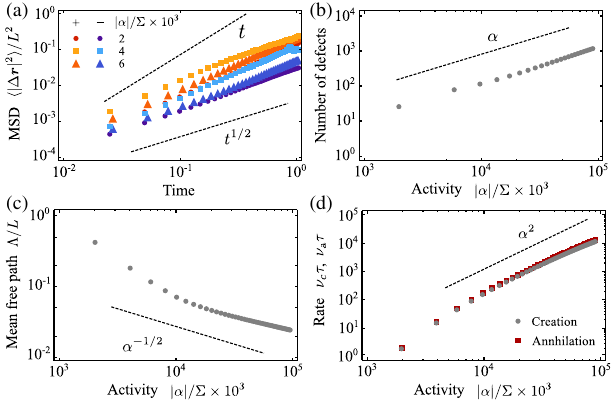
FIG. 7. (a) Mean-squared displacement of þ 1 = 2 (red tones) and − 1 = 2 (blue tones) disclinations versus time for various activity values. Number (b), mean free path (c), and rates of creation and annihilation (d) of (cid:3) 1 = 2 disclinations versus